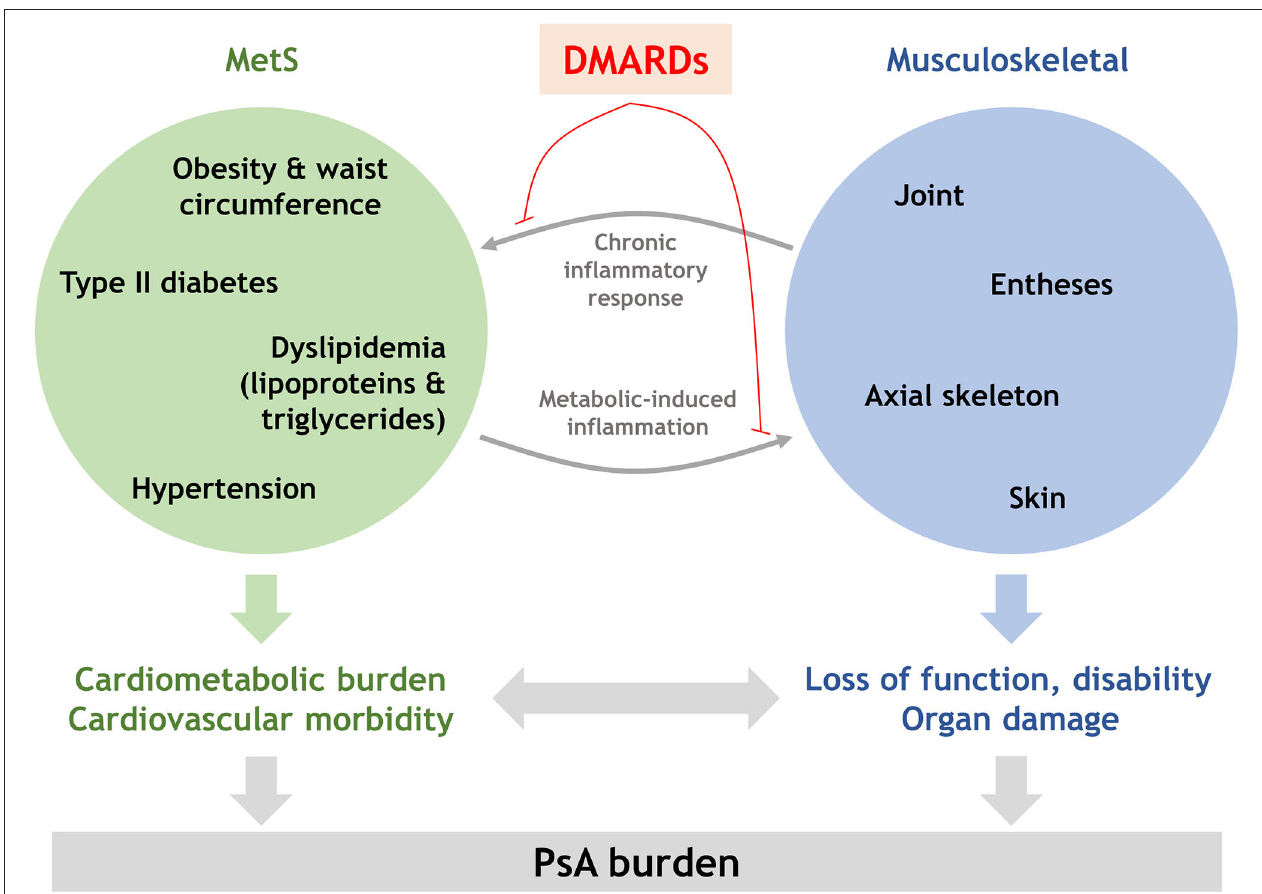
FIGURE 1 | Integrative model for the interplay between musculoskeletal and MetS domains in PsA. Musculoskeletal and MetS involvement may be connected through shared inflammatory mechanisms, thus explaining the higher disease activity indices and poor therapeutic outcomes in PsA patients with MetS and the MetS aggravation in patients with active disease or higher severity. Since this crosstalk seems to be orchestrated by inflammatory circuits, dampening inflammation by DMARDs exposure may lead to a better disease control, MetS mitigation and thus, decreased PsA